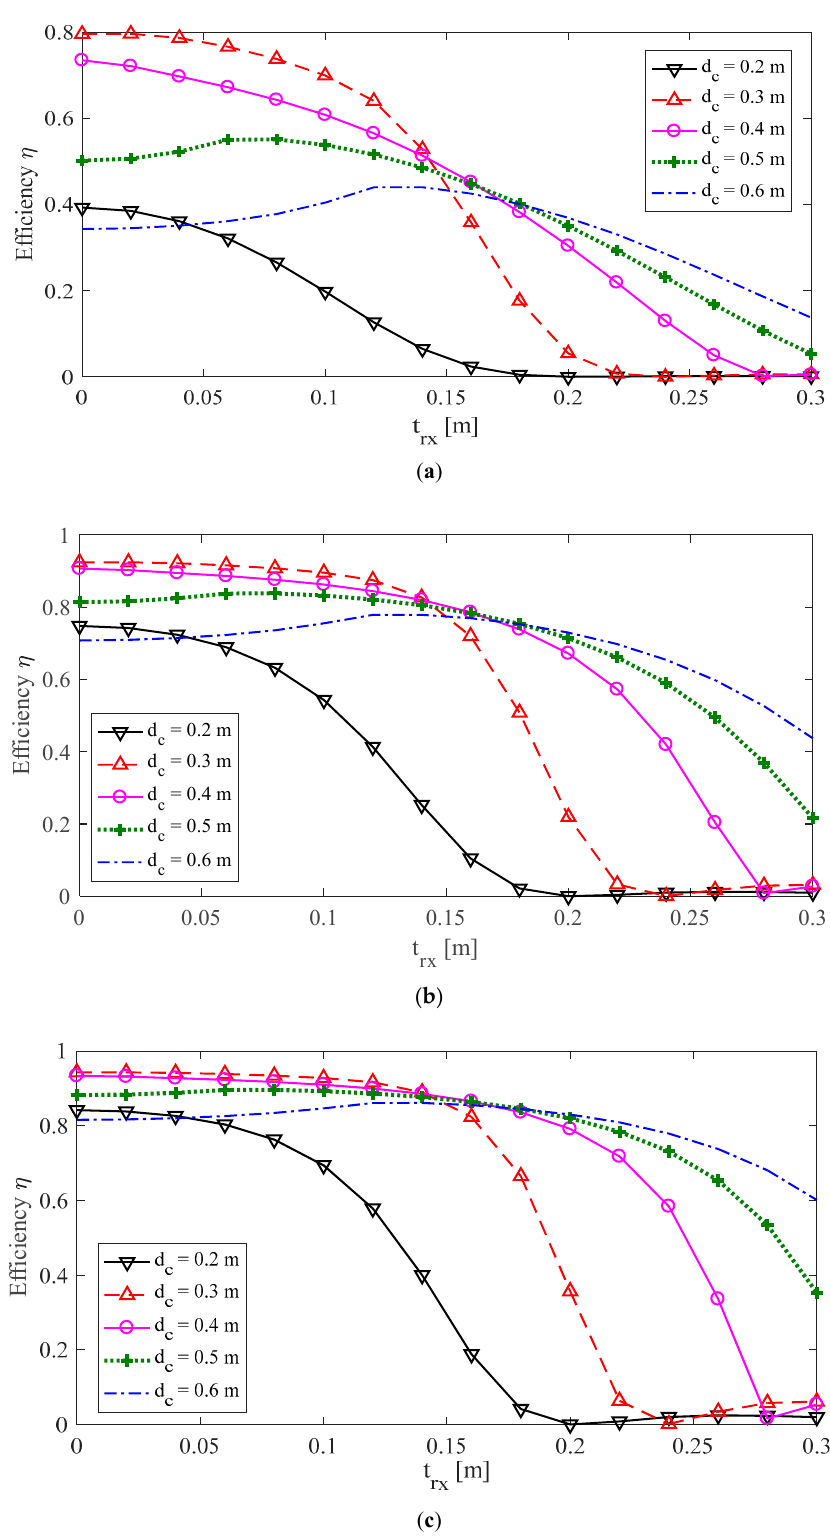
Figure 9. E ffi ciency η vs lateral misalignment t rx along x -axis for di ff erent values of the primary coil Figure 9. Efficiency η vs lateral misalignment t rx along x -axis for different values of the primary coil turns: N 1 = 1 ( a ), N 1 = 5 ( b ), and N 1 = 10 ( c turns: N 1 = 1 ( a ), N 1 = 5 ( b ), and N 1 = 10 ( c ).